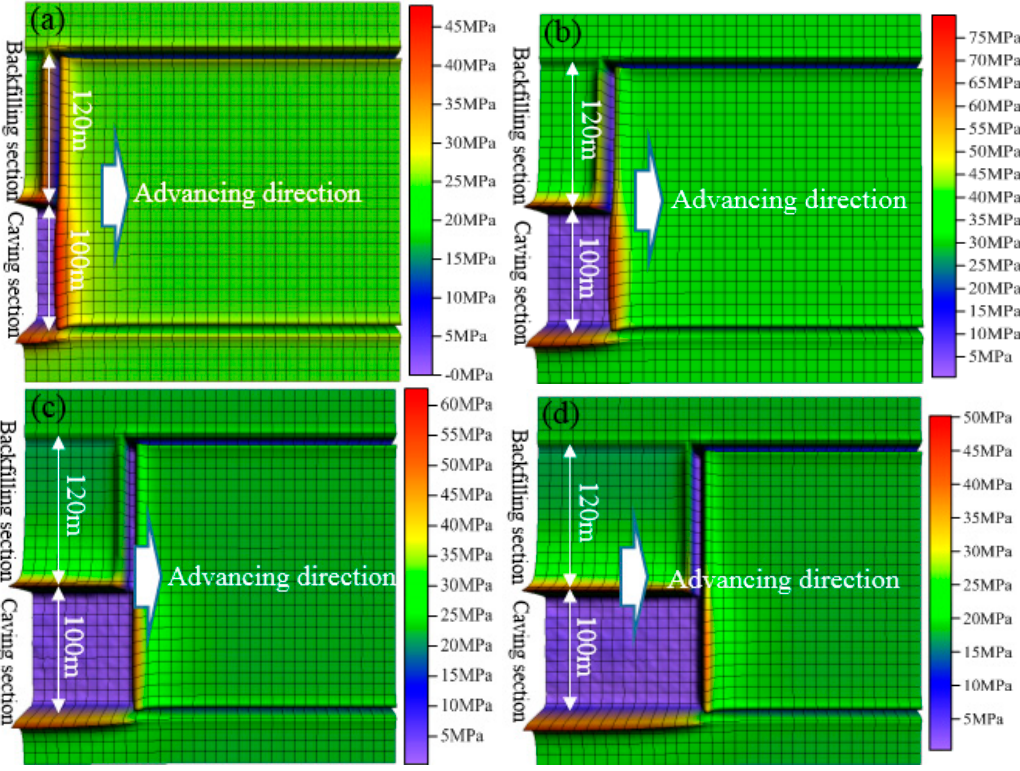
Figure 9. Evolution of the stress field of BCMM as the coalface advances: method. ( a ) Face advance of 20 m; ( b ) face advance of 50 m; ( c ) face advance of 80 m; ( d ) face advance 120m.